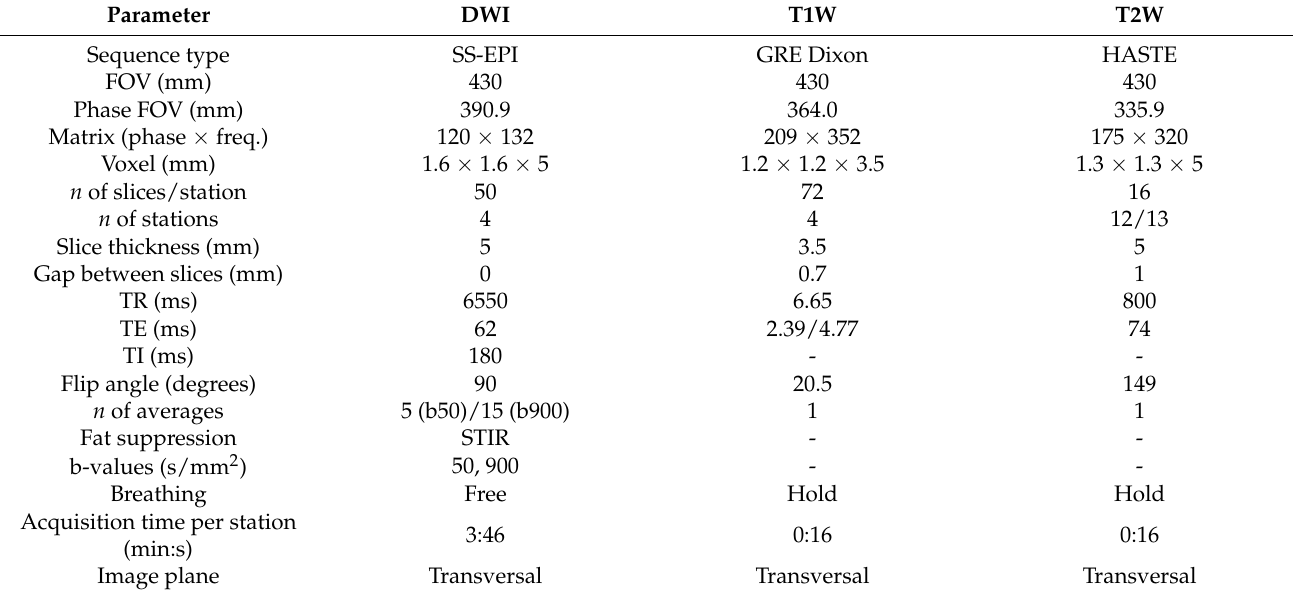
Table 1. Whole-body MRI sequence parameters of the protocol used for early cancer